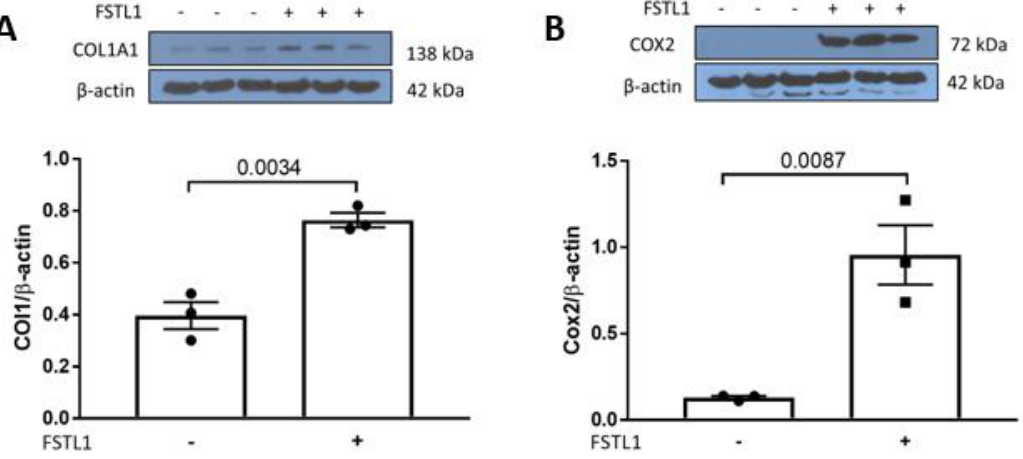
Figure 12. rhFSTL1 treatment of cultured human kidney cells. ( A ) Representative Western blots for collagen type I alpha1 chain (COL1a1) and β -actin in immortalized human proximal tubule epithelial cells treated with rhFSTL1 for 24 h. Densitometry intensities were quantified and normalized to total ( n = 3). ( B ) Representative Western blots for cyclooxygenase 2 (COX2) and β -actin in immortalized human proximal tubule epithelial cells that were treated with rhFSTL1 for 24 h. Densitometry intensities were quantified and normalized to total ( n = 3). Values are the mean ± SEM (black bars). p values were determined by Student’s t tests, and significance was defined as a p value < 0.05.